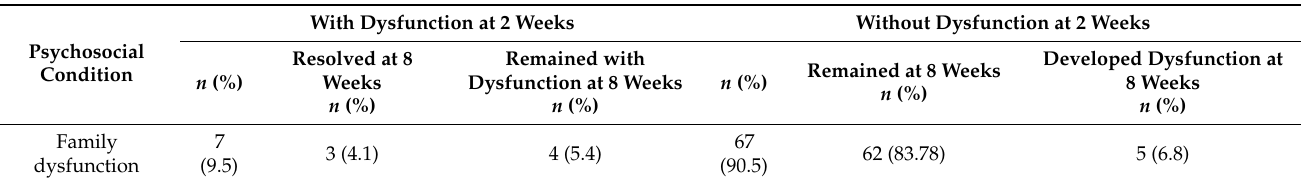
Table 5. Dynamics of perceived family dysfunction among adult patients and family members at 2 and 8 weeks after discharge of their relatives with COVID-19 from the study sites ( n = 74).